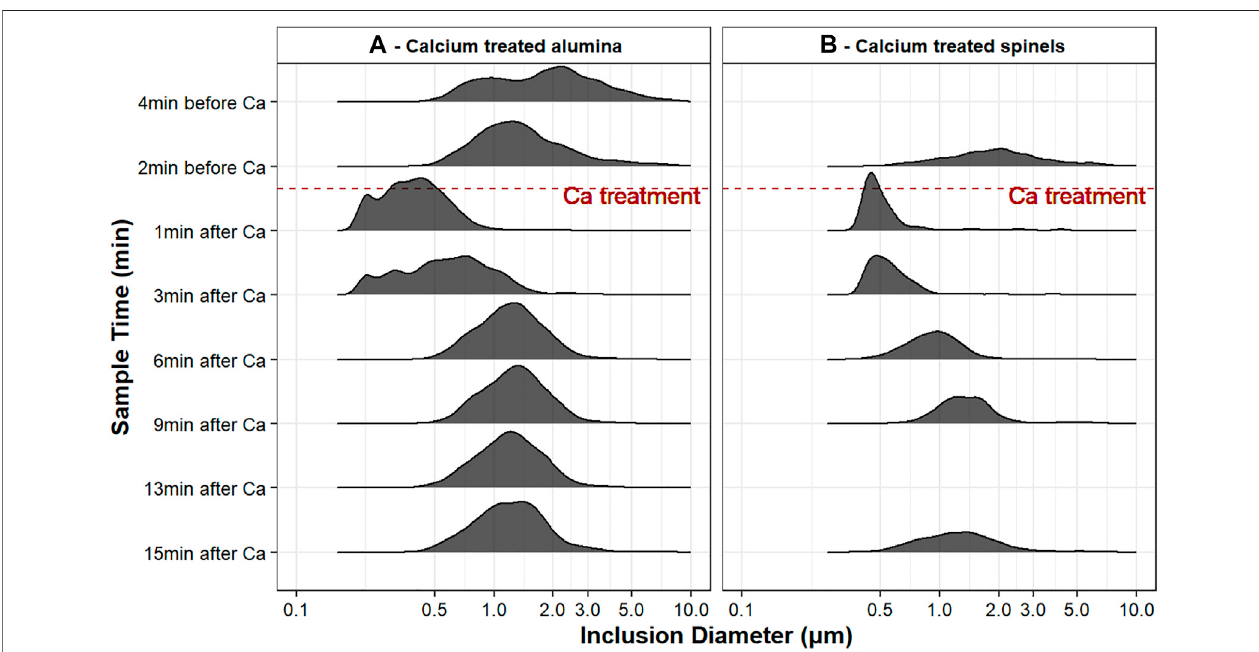
FIGURE 5 | Ridgeline plot of inclusion size distributions for both experiments, in samples taken at different times; note that the inclusion diameter is on a logarithmic scale.